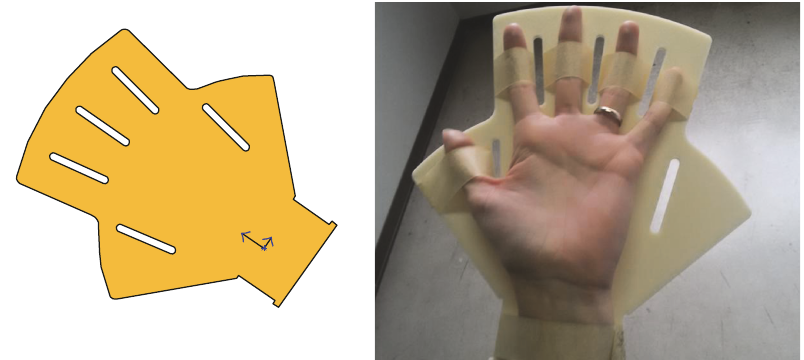
Figure 7: Support version V1: design, fabrication, and use.